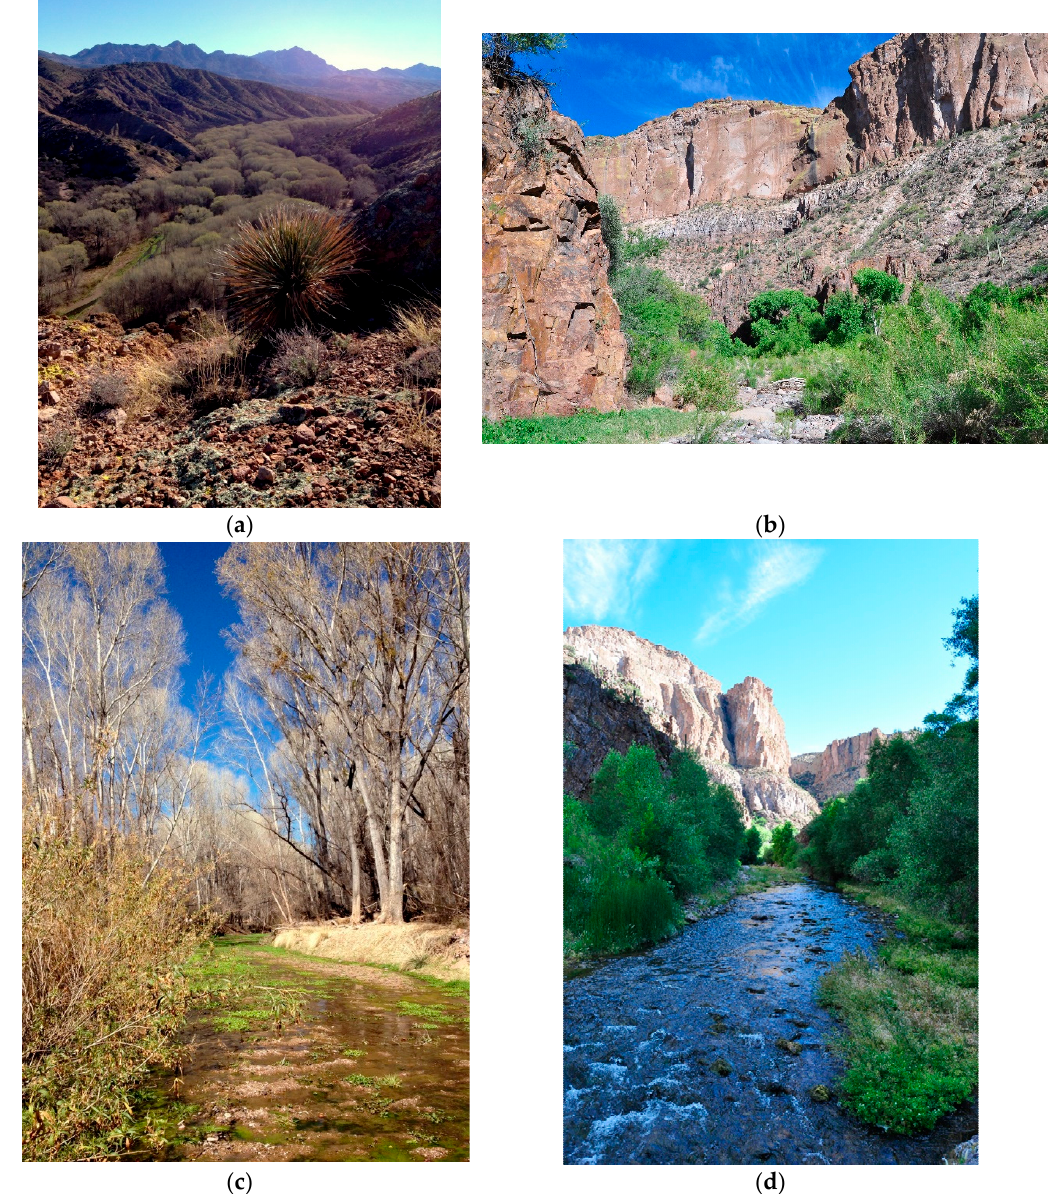
Figure 3. Photographs of ( a ) upper watershed, ( b ) narrow and deep basin, ( c ) “Aravaipa Spring” and ( d ) mainstem of creek.